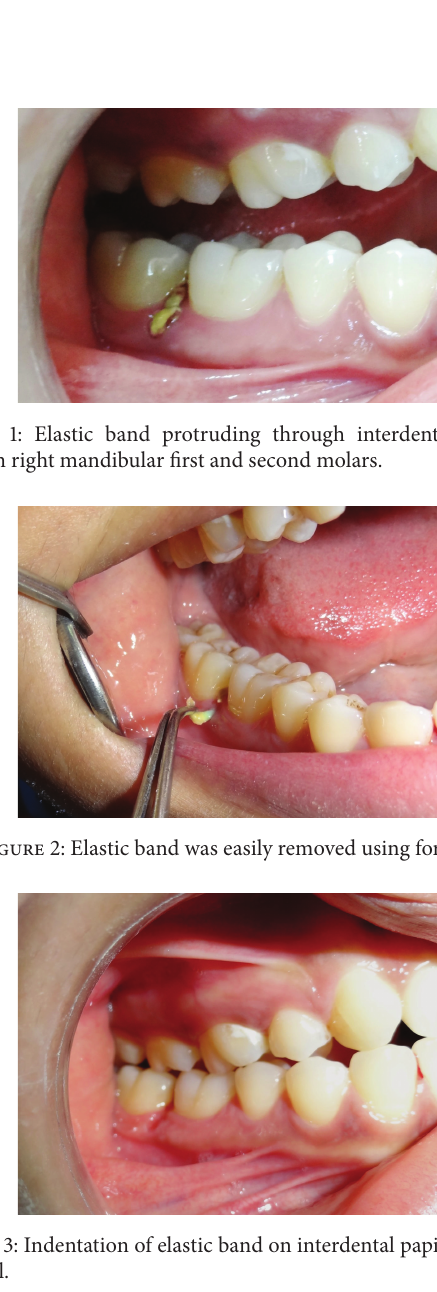
Figure 6: Completely healed gingiva after 1